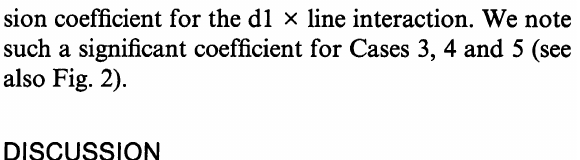
viewing condition and line length is significant for all subjects, except Case